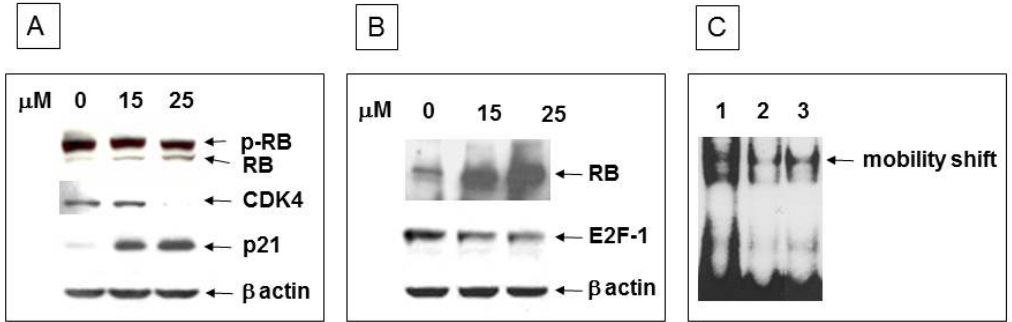
Figure 4. Protein expression analysis of RB-E2F-1 interaction and EMSA in PANC-1 cells: ( A ) 10 µg protein extracts of control and ritonavir-treated cells were resolved by SDS-PAGE, transferred to a nitrocellulose membrane, and probed with RB, CDK4, and p21 as indicated. β actin was used as a loading control. p-RB: hyper-phosphorylated retinoblastoma protein; ( B ) Upper panel: Indicated concentrations of ritonavir-treated cell lysates were immunoprecipitated with E2F-1 polyclonal antibody and probed with RB monoclonal antibody. Middle panel: Western blot analysis for E2F-1 in cells treated with indicated ritonavir concentrations. Bottom panel: control β actin levels; ( C ) EMSA with E2F-1 consensus binding site. Lane 1: Control nuclear extract; Lane 2: Nuclear extracts of lentiviral E2F-1 knockdown PANC-1 cell line; 3: Nuclear extracts of 25 µM ritonavir-treated